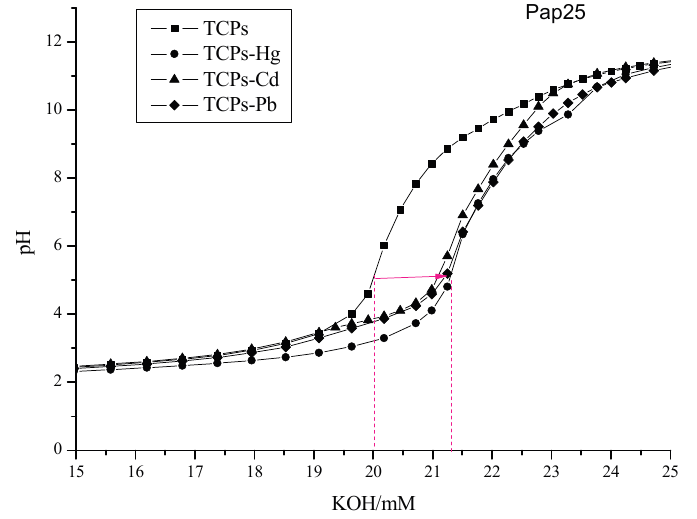
Figure 4. pH titration curves of TCPs and TCPs ( ■ ) in the presence of Hg 2+ ( ● ), Cd 2+ ( ▲ ) or Pb 2+ ( ◆ ) at 25 °C, I = 0.1 M KCl. The red solid line pointing right emphasizes